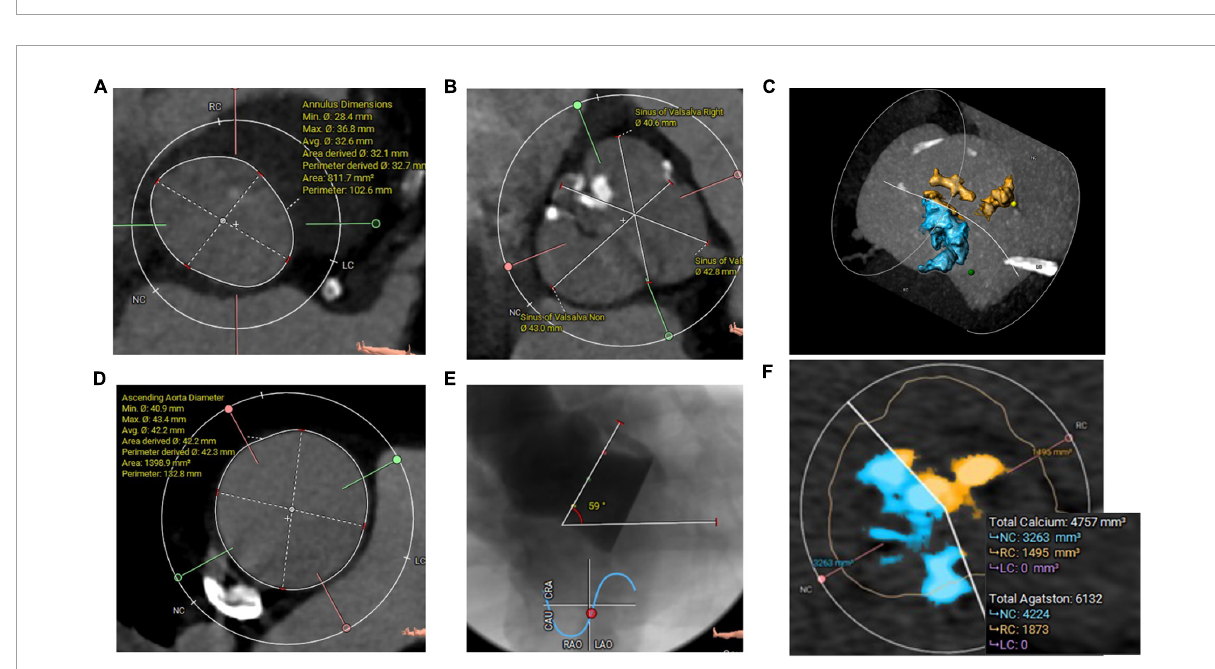
FIGURE3 (A) CCTA Annulus measurements with a very large area, (B) wide sinuses, (C) all calcifications (3D Hockey Puck-MIP view), (D) ascending aorta diameters, (E) angiographic aortic angulation showed horizontal aorta, and (F) aortic valve calcifications (Agatston and volume mm 3 ) measured from non-contrast CT